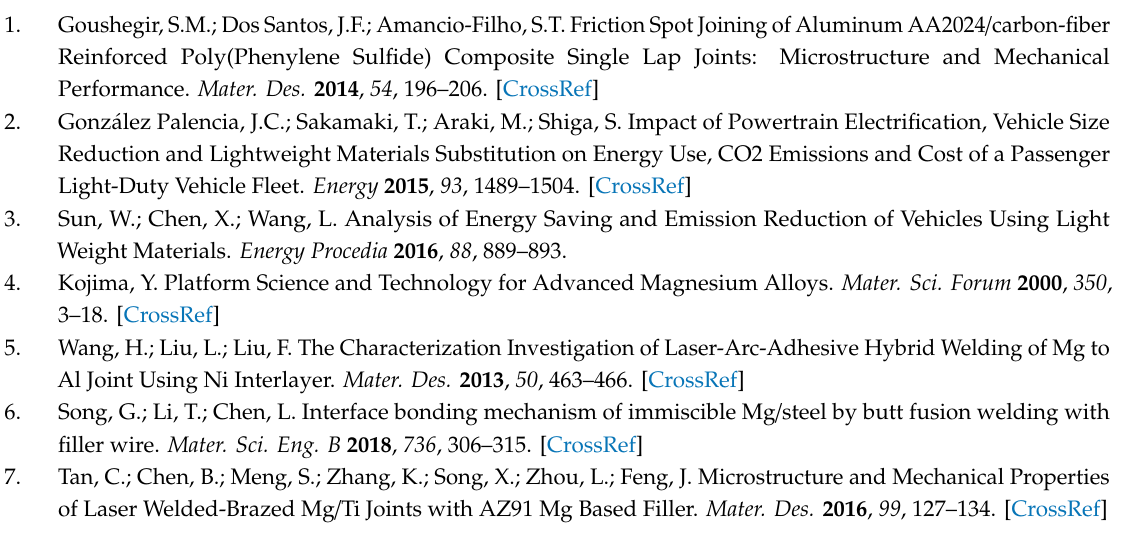
Figure 12. The diagram of the interfaces.